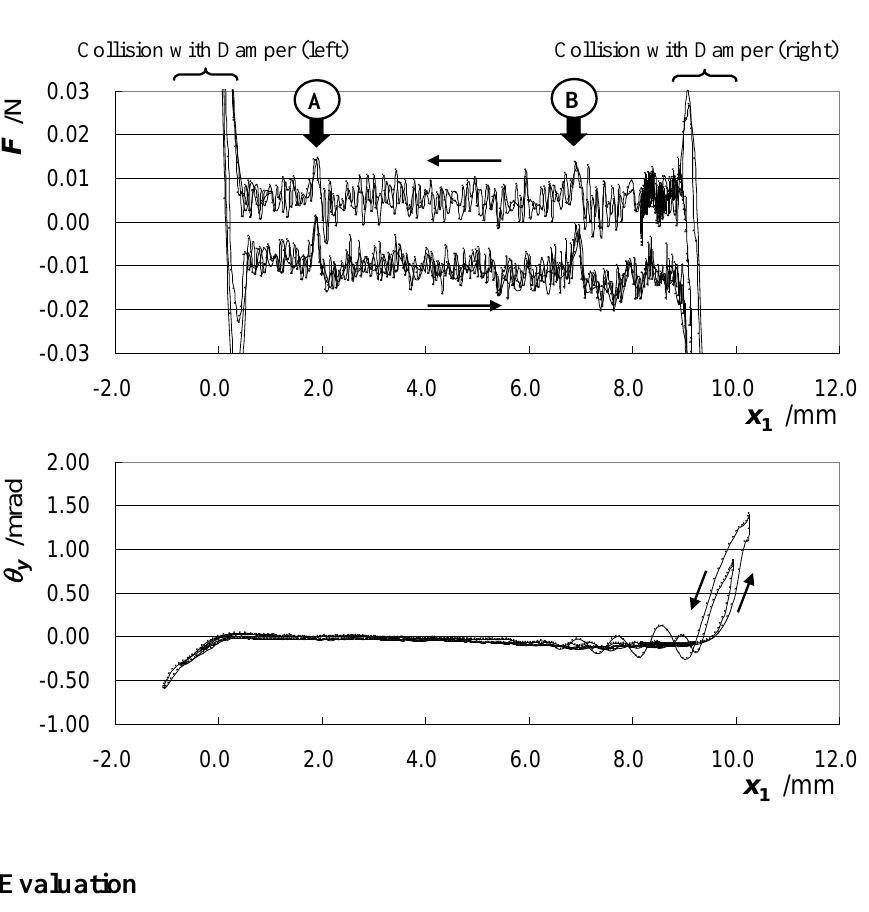
Figure 6. Change in total force acting on the moving part and pitching angle of the moving part against